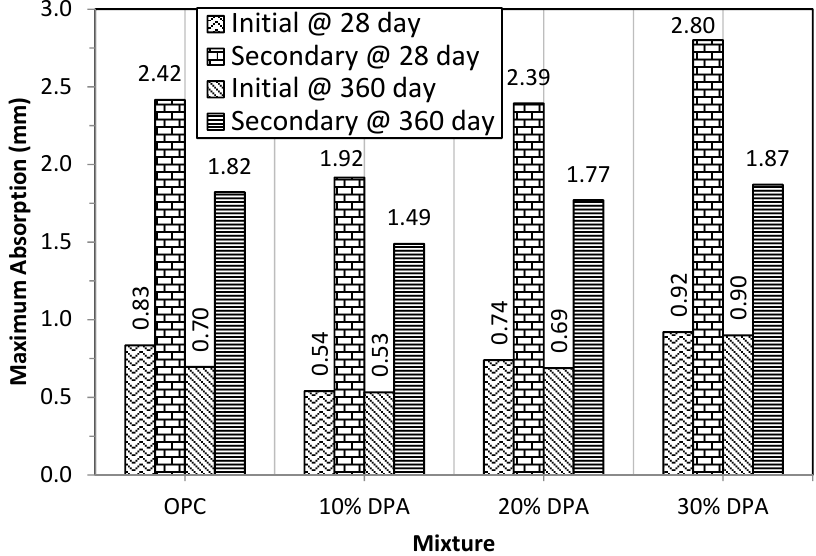
Figure 5. Maximum initial and secondary rate of water absorption in all concretes.